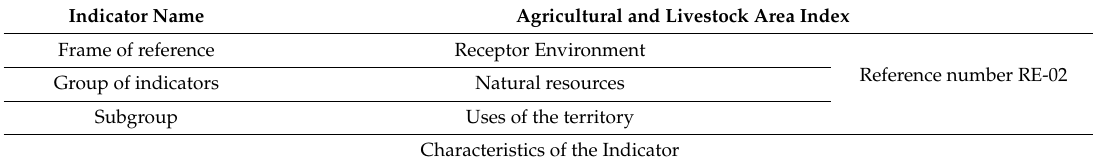
Table 1. Example of an